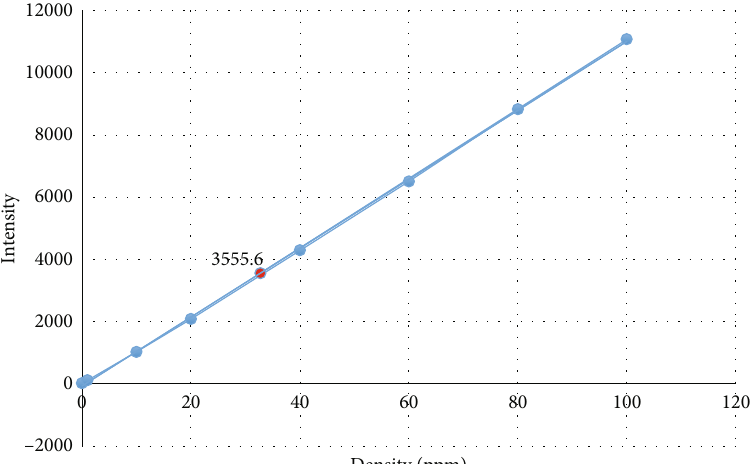
Figure 4: Calibration curve of concentration of standard selenium solutions.